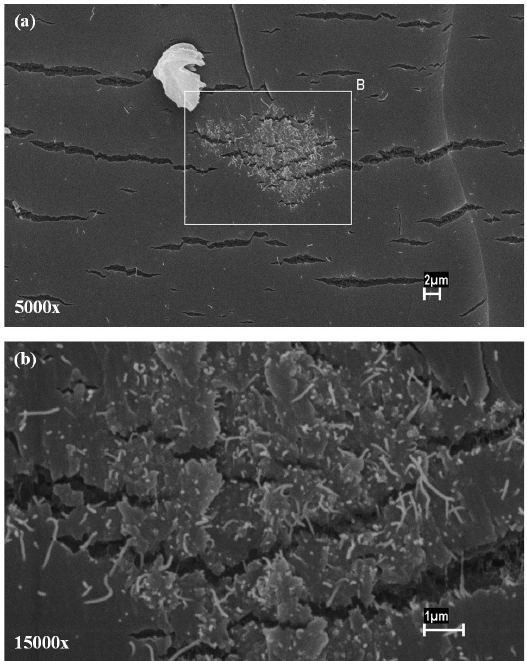
Figure 1. SEM of nanocomposite containing 0.1% (w/w) CNT: the network of dispersed CNTs is visible as white/black spots throughout the material (a) and island detail in the surface (b).